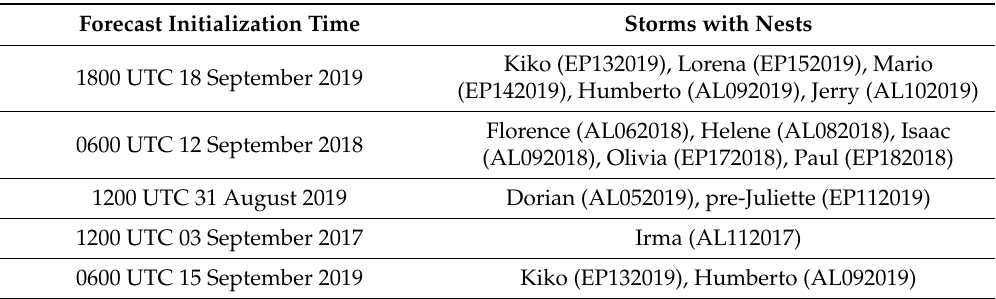
Table 1. Forecast initialization times used for HWRF-B case studies, showing corresponding active TCs with high-resolution nests coupled to MPIPOM-TC by the new coupling scheme. Forecast Initialization